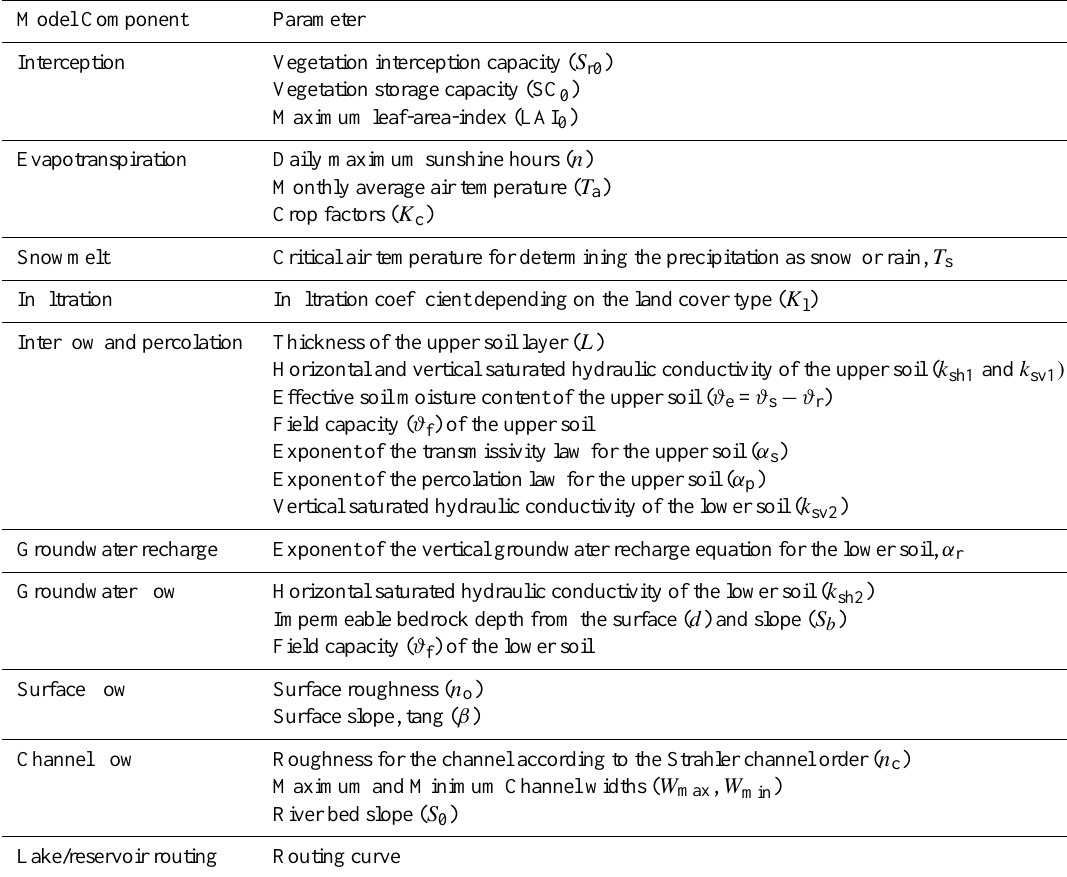
Table C1. Principal parameters required for each grid cell in the new TOPKAPI model. Model